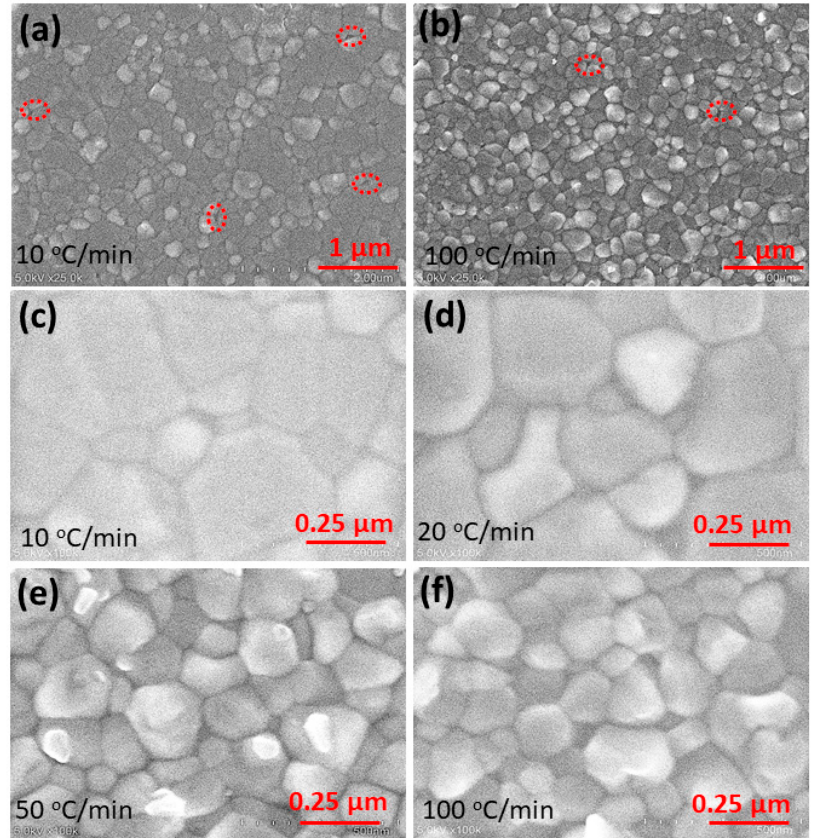
Figure 2. Microstructures of the Y 2 O 3 ceramics fabricated with various heating rate; low magnification images of the samples fabricated at ( a ) 10 and ( b ) 100 °C/min, and high magnification images of the samples fabricated at ( c ) 10, ( d ) 20, ( e ) 50 and ( f ) 100 °C/min.